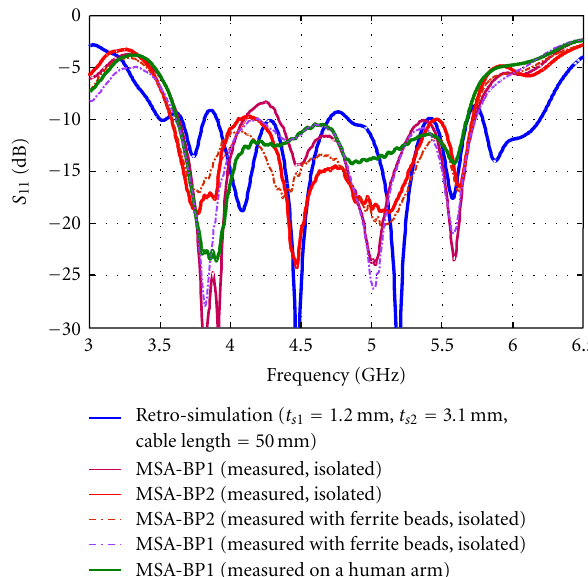
Figure 9: Simulated and measured reflection coe ffi cient of the MSA-BP, either isolated or on a human arm (male, 1.75 m and 75kg).